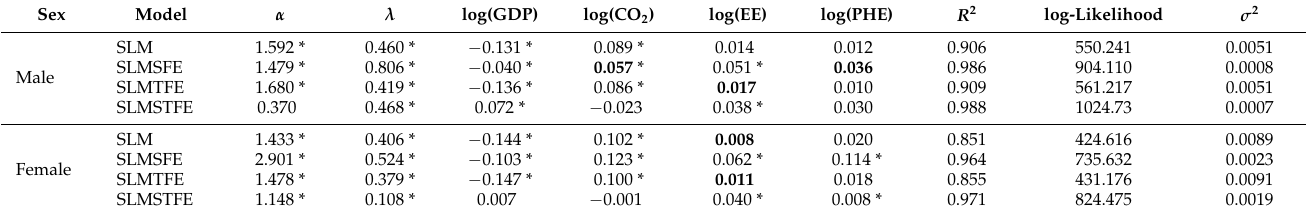
Table 3. Model fittings using the sar_panel_FE function in MATLAB by sex.